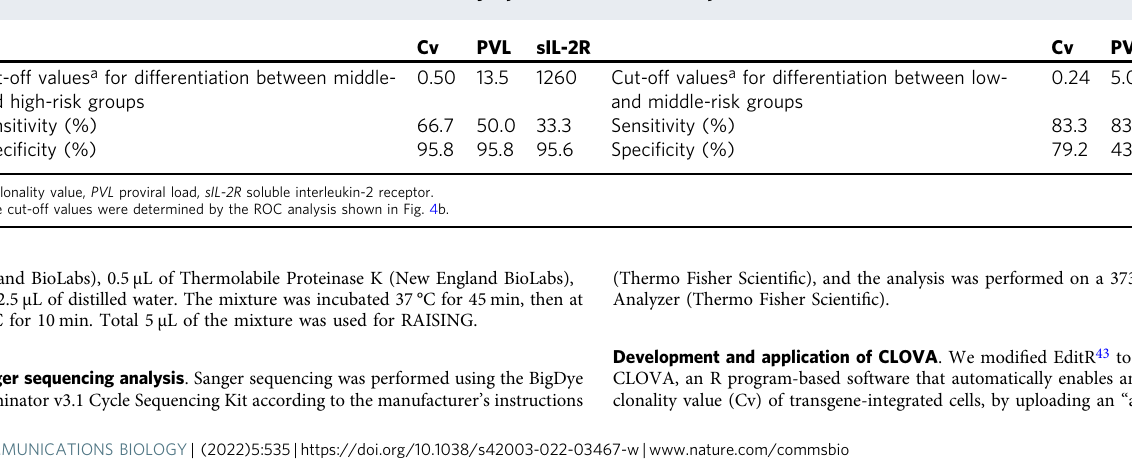
England BioLabs), 0.5 μ L of Thermolabile Proteinase K (New England BioLabs), and 2.5 μ L of distilled water. The mixture was incubated 37 °C for 45min, then at 55°C for 10 min. Total 5 μ L of the mixture was used for RAISING. Sanger sequencing analysis . Sanger sequencing was performed using the BigDye Terminator v3.1 Cycle Sequencing Kit according to the manufacturer ’ s instructions